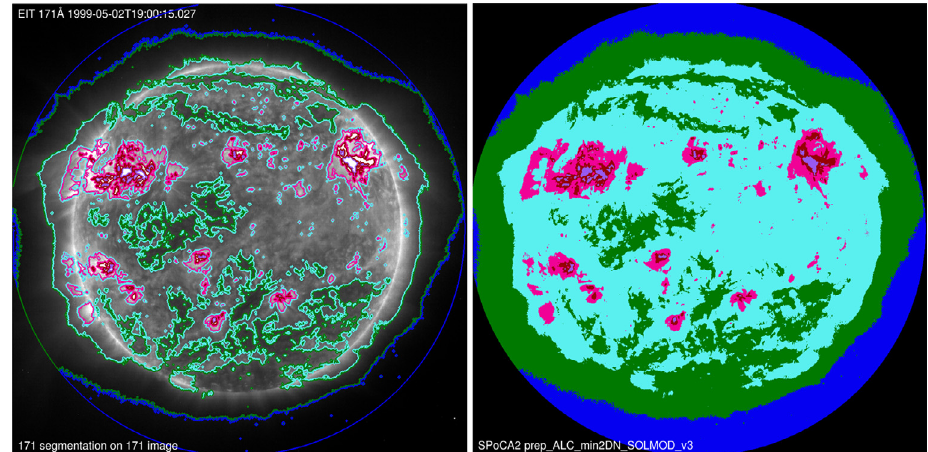
Fig. 7. The left panel shows the segmentation as an overlay on the original EIT 171 Å image recorded on 2 May 1999 at 19:00:15. The right panel shows the segmentation map produced with the center values derived from SOLMOD.